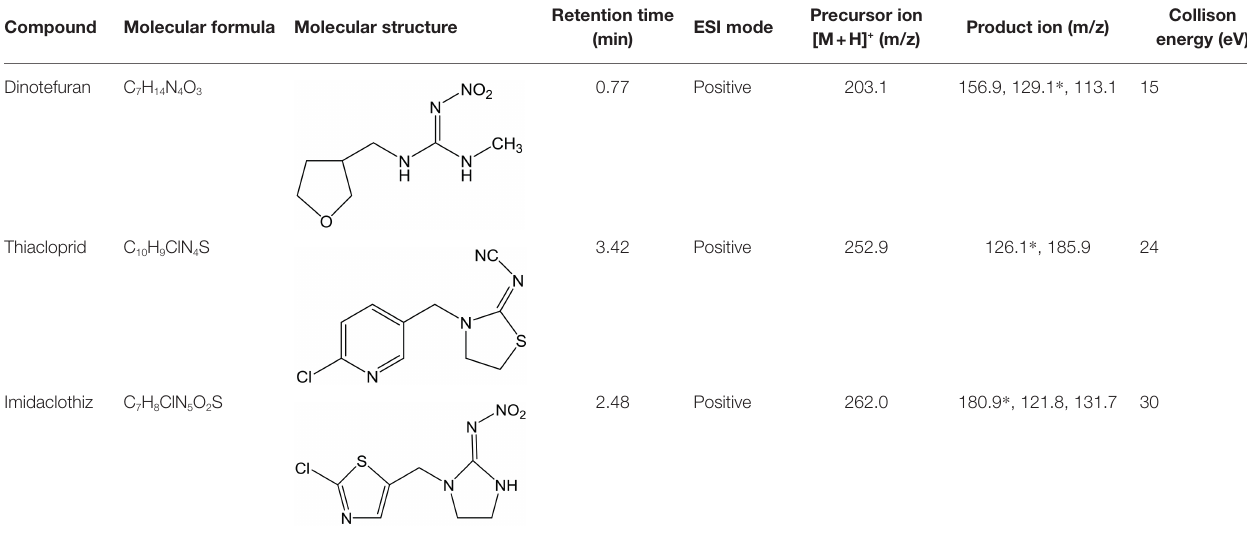
TABLE 1 | Information and HPLC-MS/MS parameters for dinotefuran, thiacloprid, and imidaclothiz.